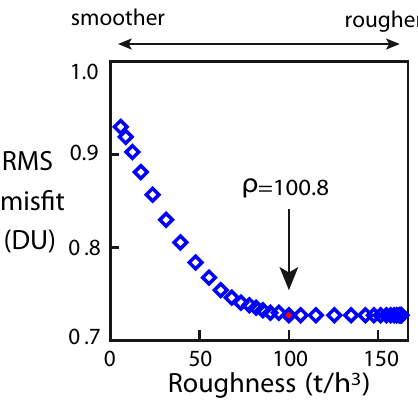
Fig. 1. Normalised RMS misfit (in Dobson units) as a function of solution roughness (th − 3 ), using the complete time series of IASI satellite observations (from 4 to 12 May 2010) in the inversion pro- cedure. The optimal roughness is indicated in